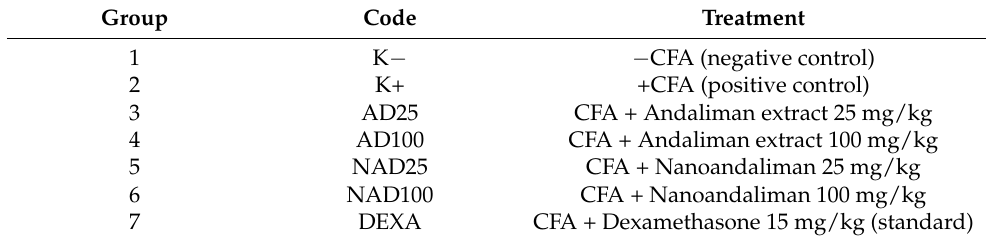
Table 1. Treatment groups of inflammatory arthritis